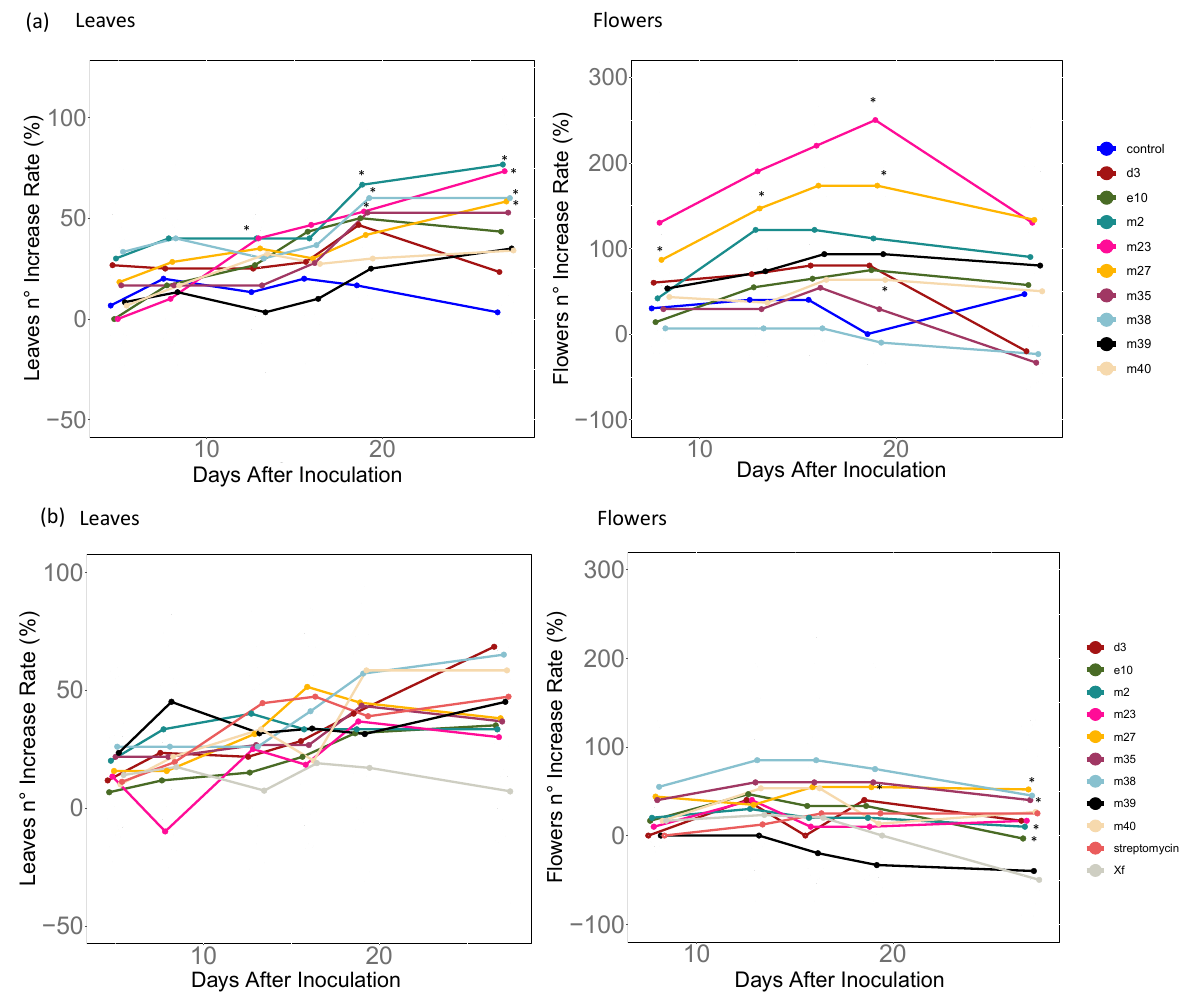
Figure 5. Leaf and flower growth over time in inoculated plants under no stress ( a ) or X. fragariae stress ( b ) conditions. Asterisks indicate parameters significantly different from the control, according to Student’s t-test at p -value < 0.05 ( n = 5).